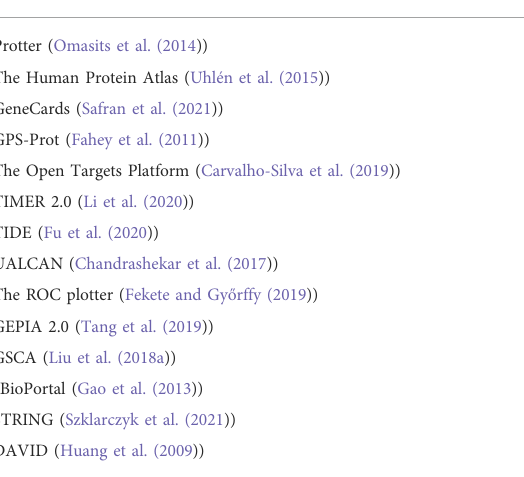
TABLE 1 Online analysis tools used in this